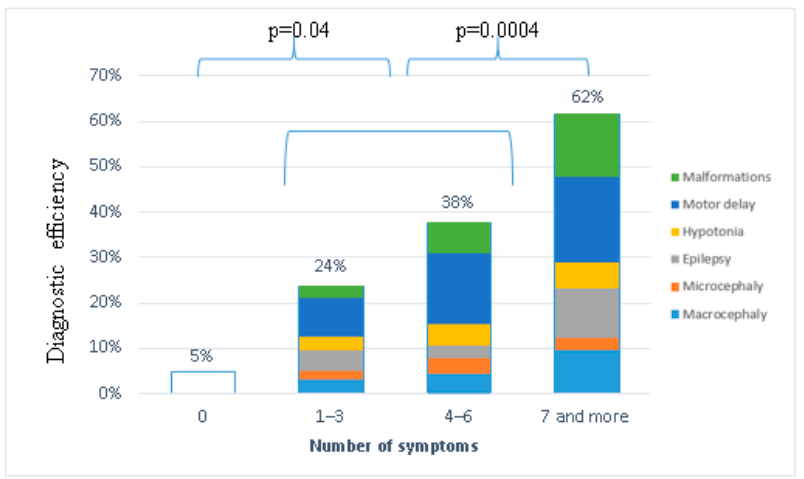
Figure 3. Diagnostic efficiency depending on the number of the major phenotypic features.